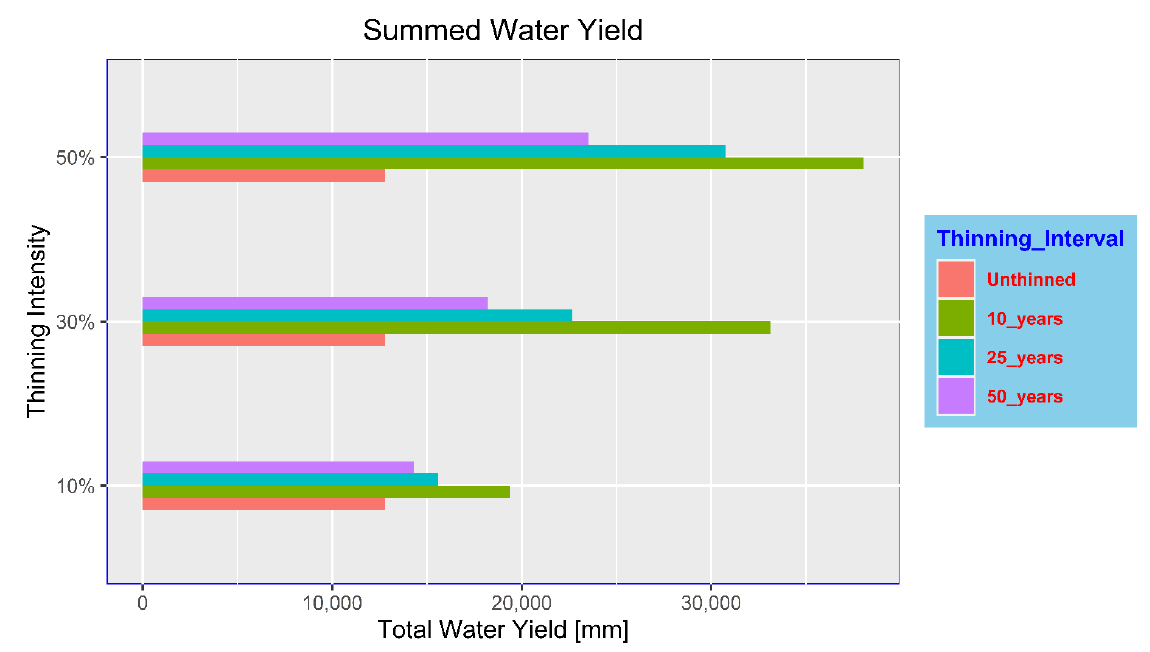
Figure 6. Total water yield over the management period. The stand biomass predicted annually by the model were summed over the manage- ment period. Light thinning at the 50 year interval produced the highest stand biomass among the thinning regimes without considering the un-thinned stand (Figure 7). Stand biomass decreased with increasing thinning intensity. Light, moderate, and heavy thinning produced 23.68%, 55.01%, and 64.43% less biomass than an un-thinned stand.